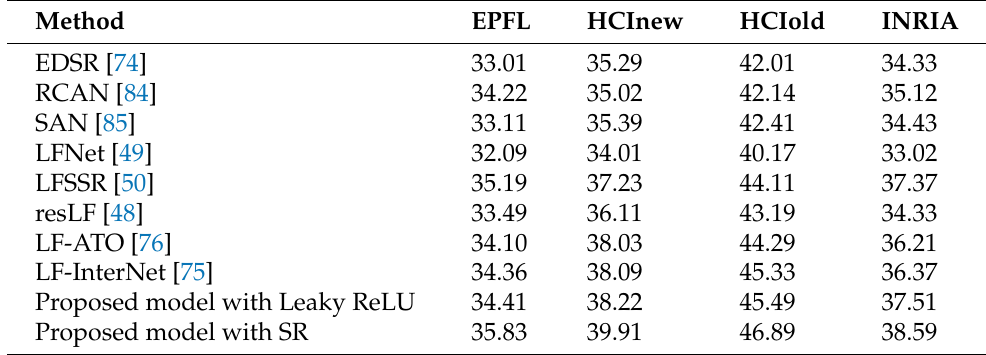
Table 2. PSNR values achieved by different methods and our proposed model model in differ- ent datasets.